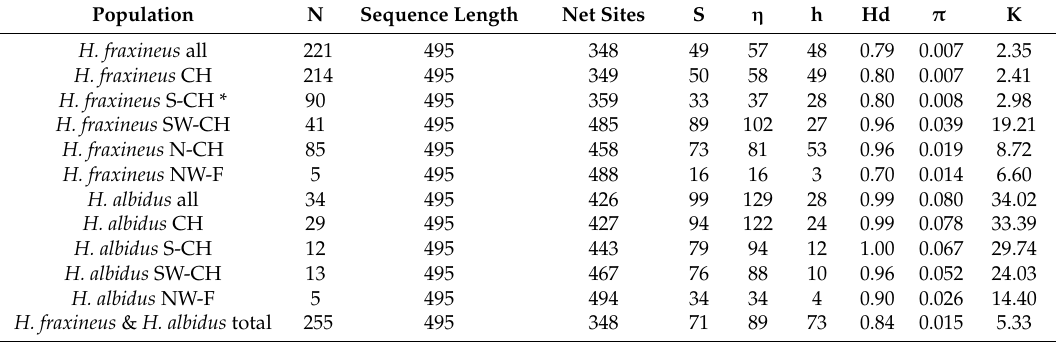
Table 3. Population genetic parameters for the partial RdRP gene sequences (495 bp) of HfMV1 recovered from Hymenoscyphus albidus and H. fraxineus .